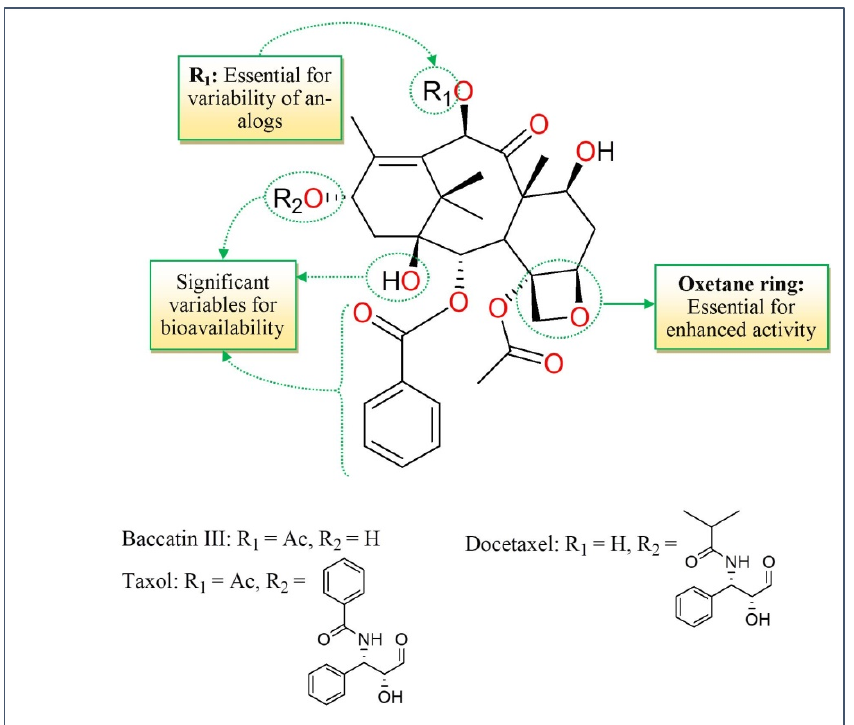
Figure 3. SAR and analogs of